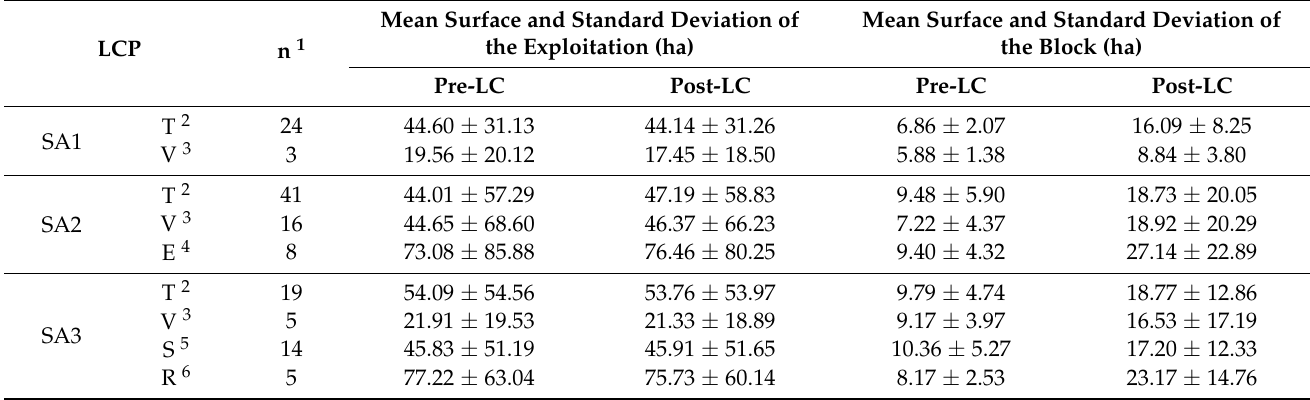
Table 4. Mean size of the exploitations and their blocks (pre-LC and post-LC).